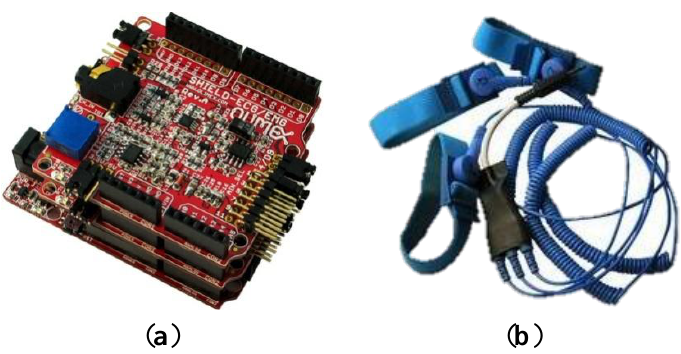
Figure 6. ( a ) Arduino, ( b ) electrodes.